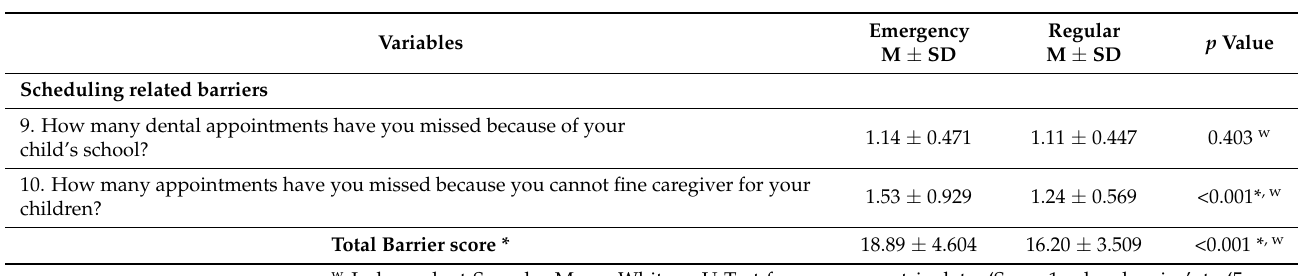
Table 4 shows a binary regression analysis of the association between visiting the ER-C and sociodemographic factors, previous dental visits, dental behaviour, DMFT/dmft, dental neglect, and dental barriers. Dental barriers (AOR: 1.121, 95% CI: 1.063 to 1.083,